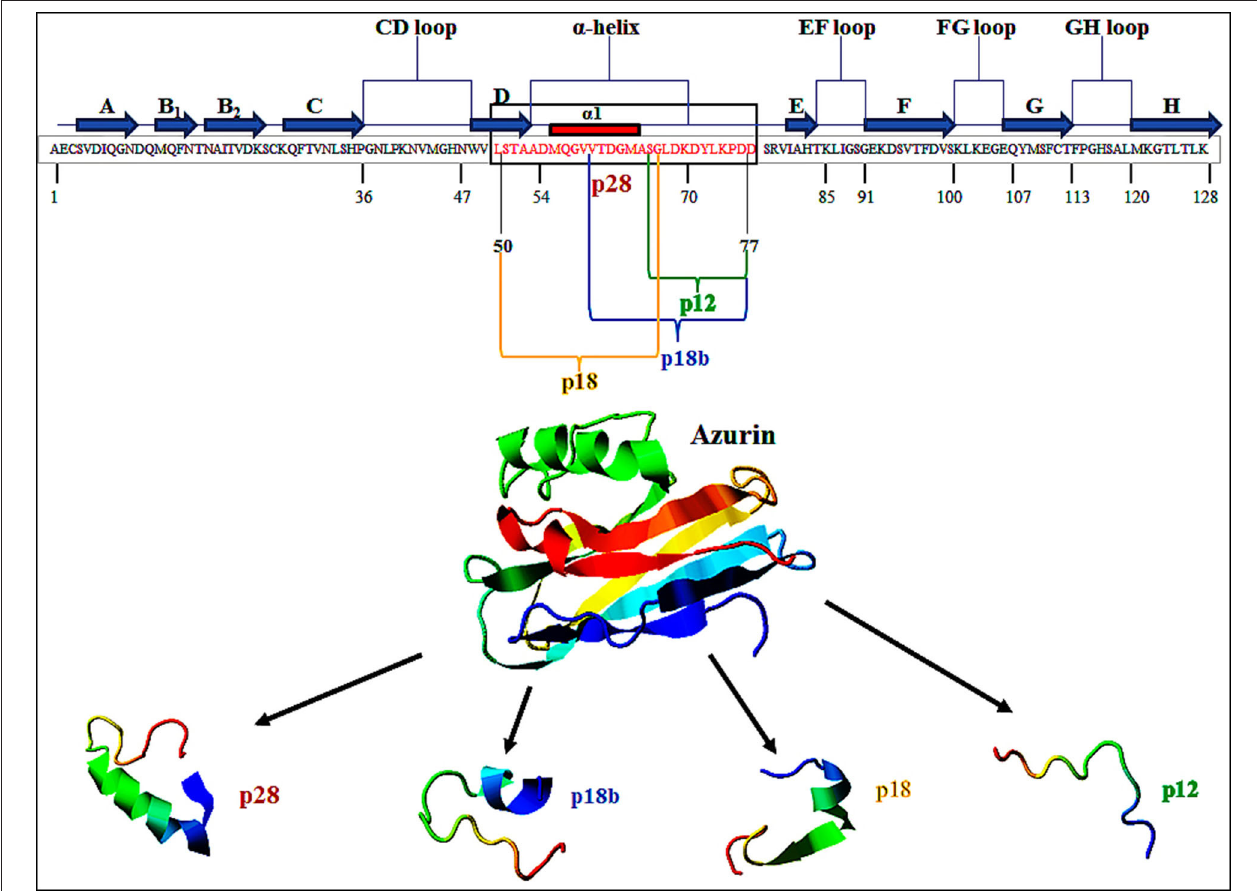
FIGURE 1 | Primary structure of azurin (128 aa). p28 sequence (28 aa) is derived from amino acids 50 to 77 (Leu50–Asp77) of azurin (in box). This figure is made with I-TASSER (https://zhanglab.ccmb.med.umich.edu/I-TASSER/).